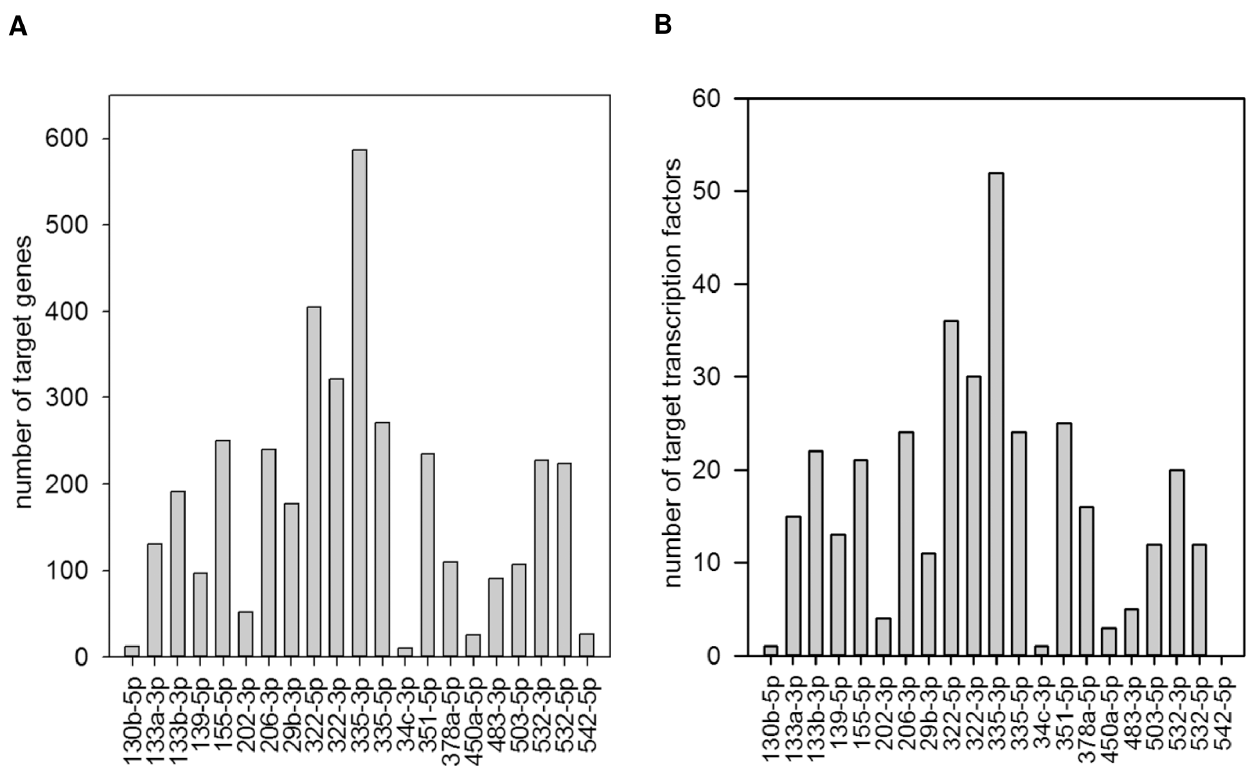
Fig 4. Abundance of targets is miRNA-specific. Joint analysis of miRNA and mRNA expression data and target prediction revealed miRNA-specific numbers of inversely associated (A) targets and (B) transcription